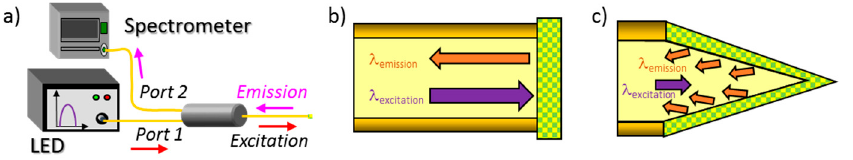
Figure 5. ( a ) Reflection set up for a luminescent sensor; ( b ) perpendicularly ended fibre and ( c ) a stretched one to get more luminescence emission coupled into the fibre.